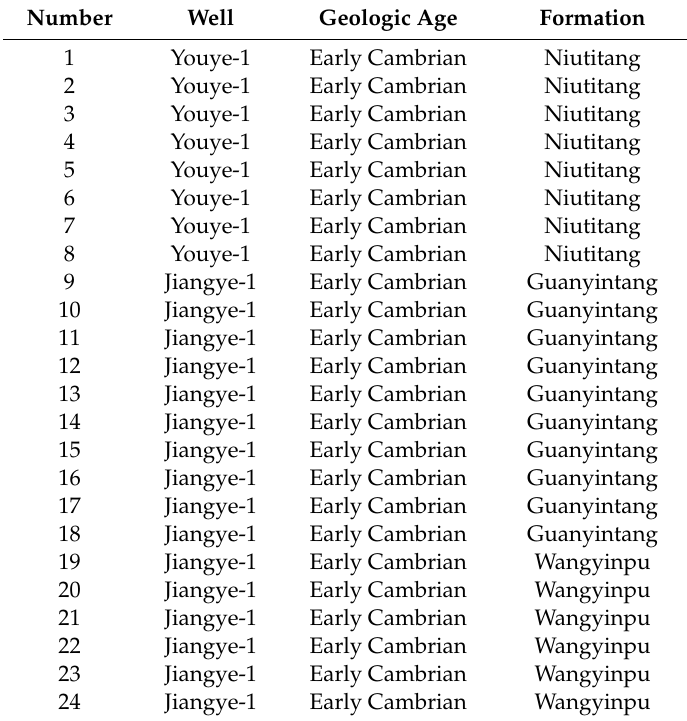
Table 1. Experimental numbers, wells, geologic age, and formation names of gas samples. The well locations can be seen in Figure